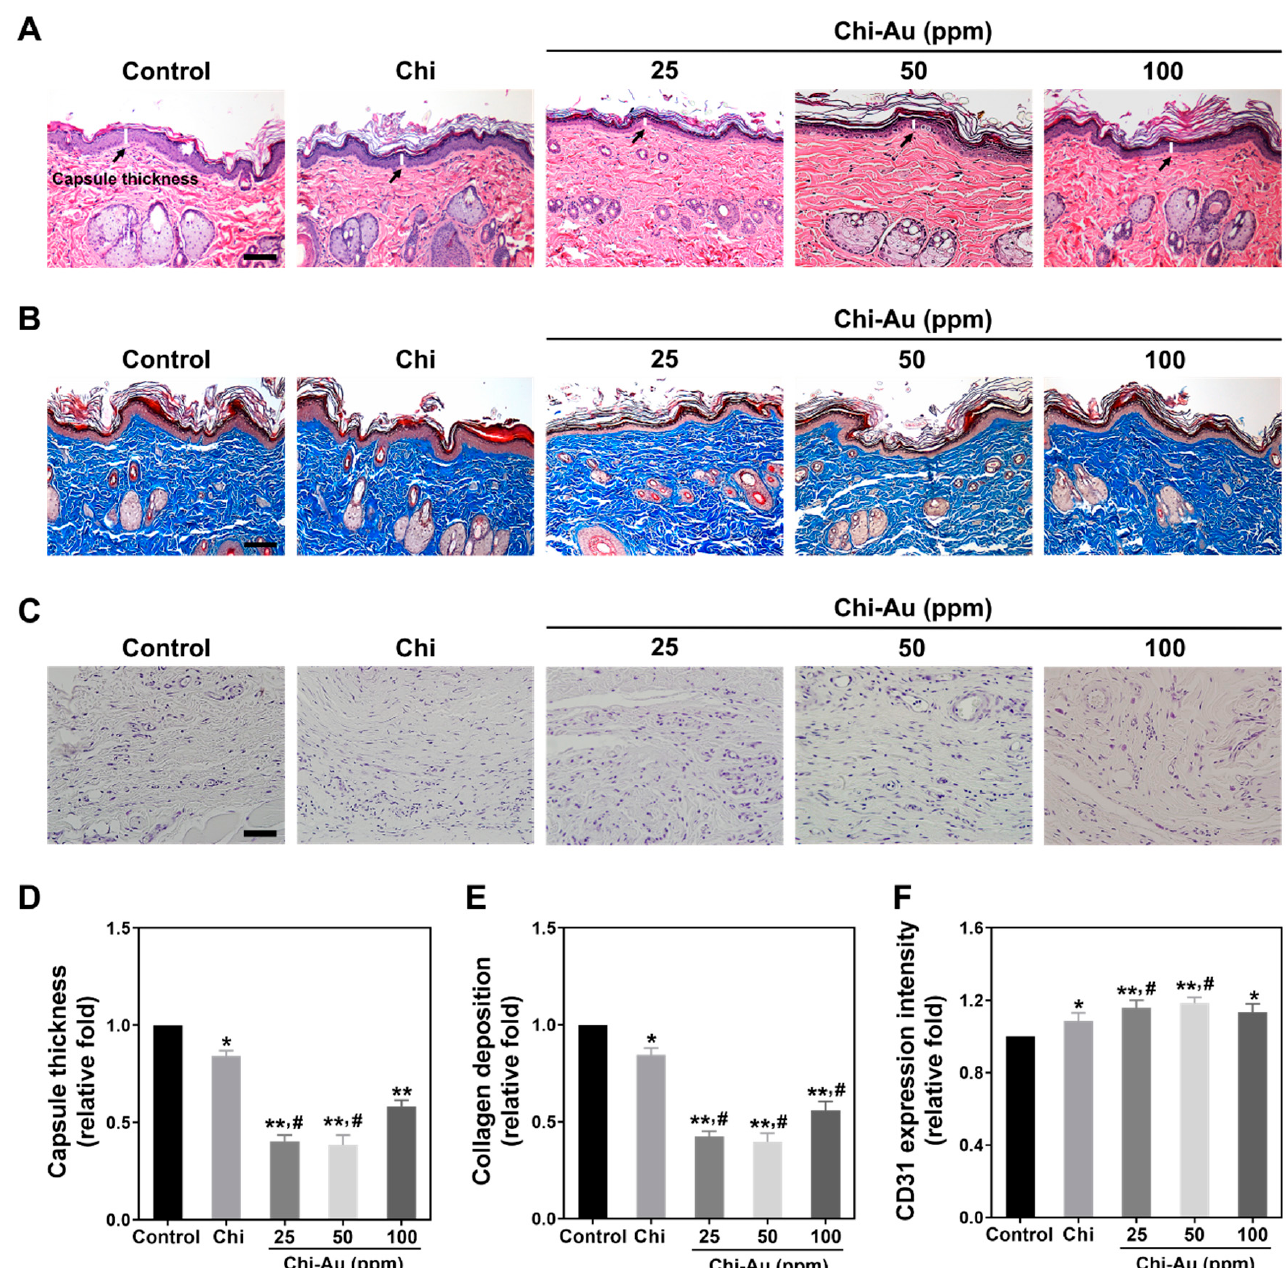
Figure 7. Histology assessments of biocompatibility in an animal model after subcutaneous implantation for four weeks. ( A ) Capsule thickness was observed by H&E staining. The black arrows show the capsule thickness induced by various Chi–Au nanocomposites. ( B ) Collagen deposition was examined by Masson’s trichrome staining (blue). ( C ) CD31 endothelial marker expression was detected by AEC staining. ( D , E ) The capsule thickness and collagen deposition in each group were semi-quantified. The results demonstrate that Chi–Au 50 ppm induced the lowest capsule formation and collagen deposition, indicating that Chi–Au 50 ppm would not significantly stimulate a foreign body response. ( F ) CD31 expression was semi-quantified. The Chi–Au 25 ppm and 50 ppm groups remarkably induced endothelialization. Scale bar was set as 100 µ m. Results are exhibited as mean ± SD ( n = 3). * p < 0.05, ** p < 0.01: compared with the control (TCPS); # p < 0.05: compared with the Chi group.